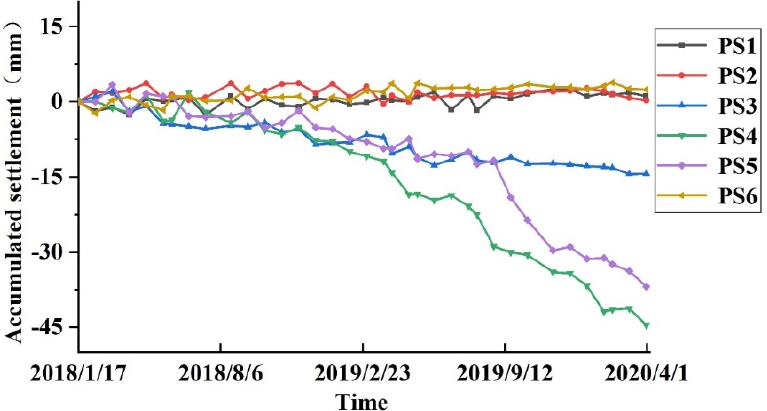
Figure 6. Subsidence time series with respect to PS points labeled as PS1–PS6 in Figure